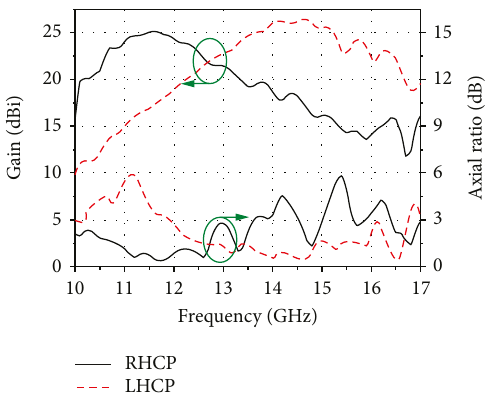
Figure 10: Measured gains and axial ratios of the re fl ectarray versus frequency under RHCP and LHCP illuminations.